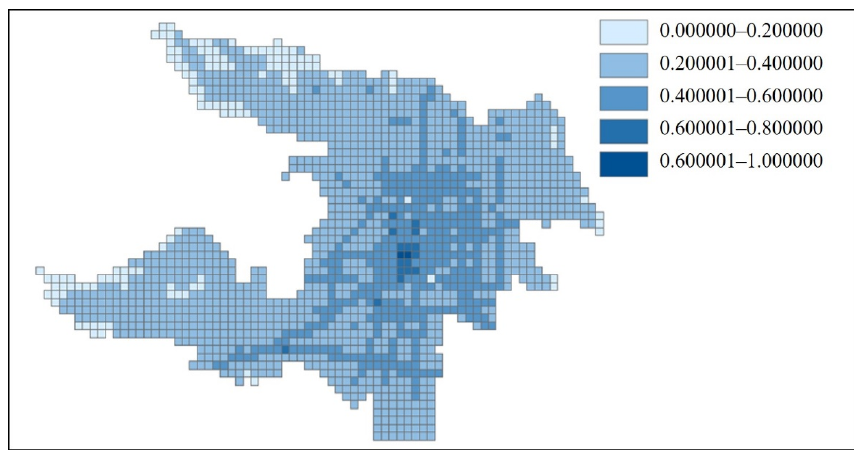
Figure 11. Visualization of the comprehensive accessibility of Zhicheng.